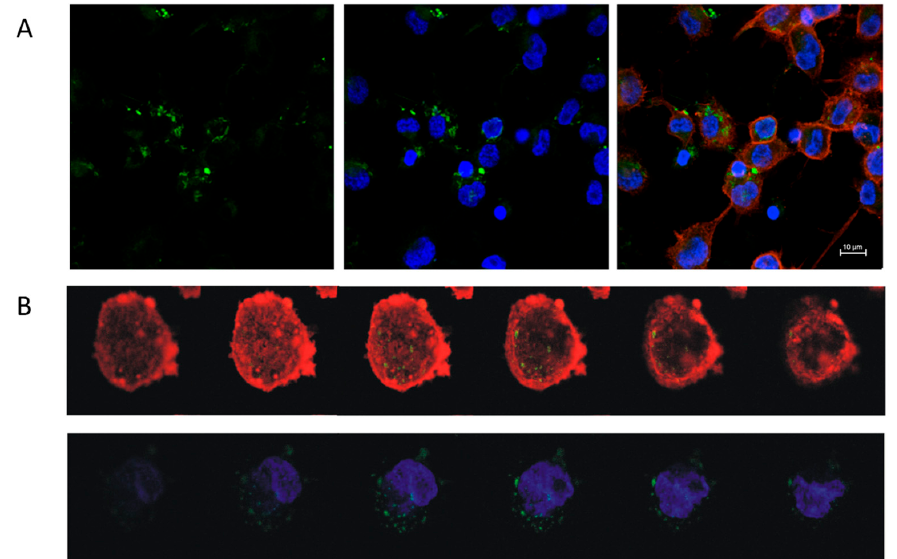
Figure 4. Uptake of EVs derived from Snail-HT29 cells (clone 17) by TDM. HT29-Snail EVs were labeled with PKH67 dye (green). Nuclei were stained with Hoechst (blue), actin was stained with Phalloidin Texas Red (red). ( A ) Representative confocal laser scanning microscope. ( B ) Z-stack analysis of cells and incorporated EVs. Note: Viability of TDM cells was not affected by the incorporation of EVs (Figure S4).